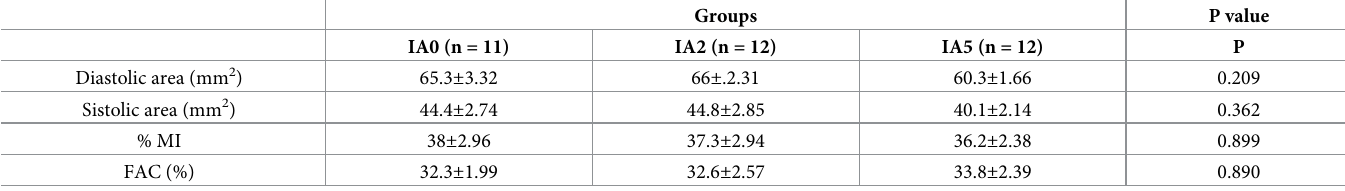
Table 1. Initial echocardiographic exam (7 days after